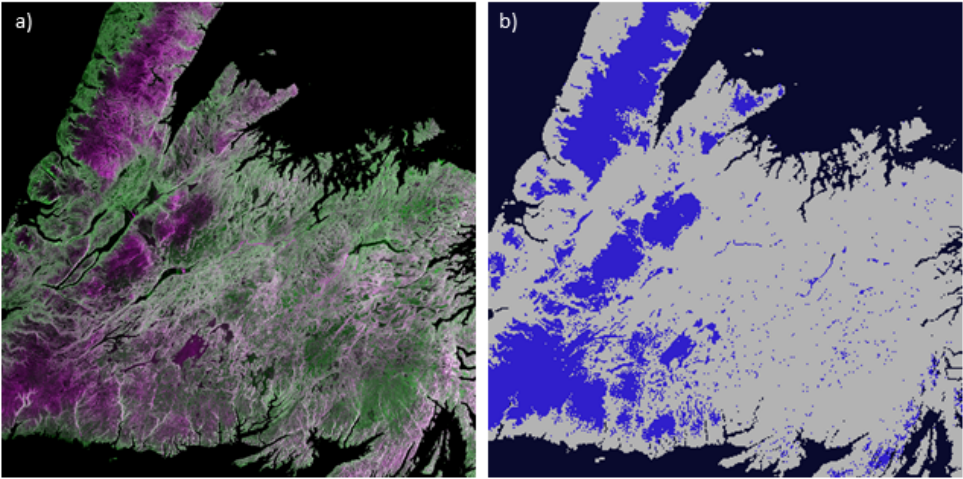
Figure 4. ( a ) Sentinel-1 IW mode composite for the Island of Newfoundland for 30 April 2017; ( b ) derived map of wet snow area (blue) from Sentinel-1